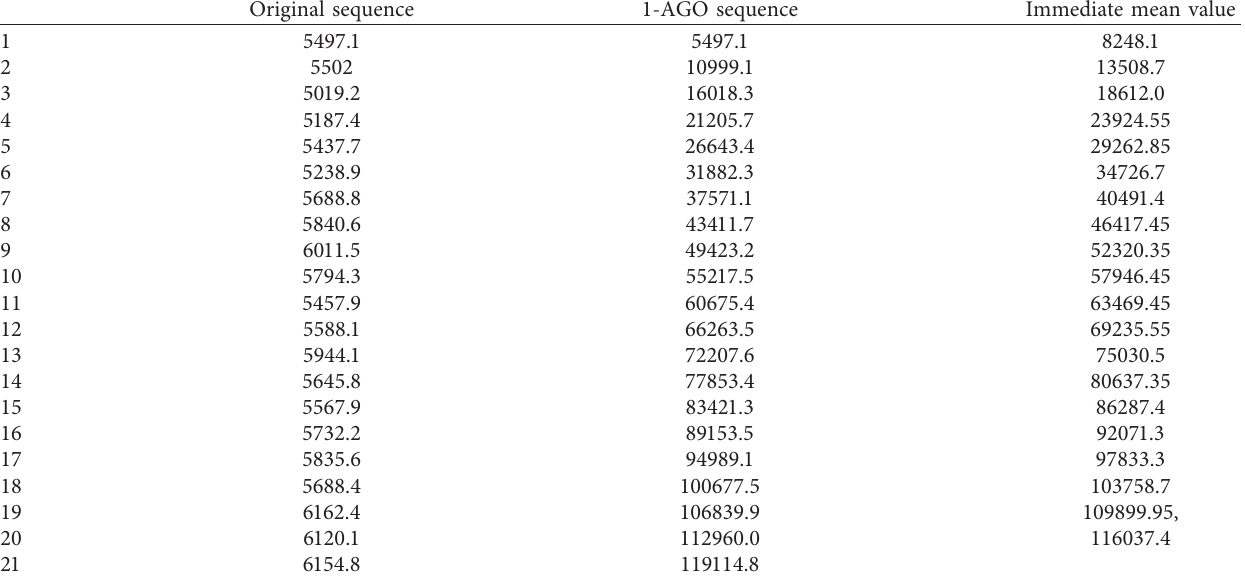
Table 6: Crude oil supply original sequence processing.